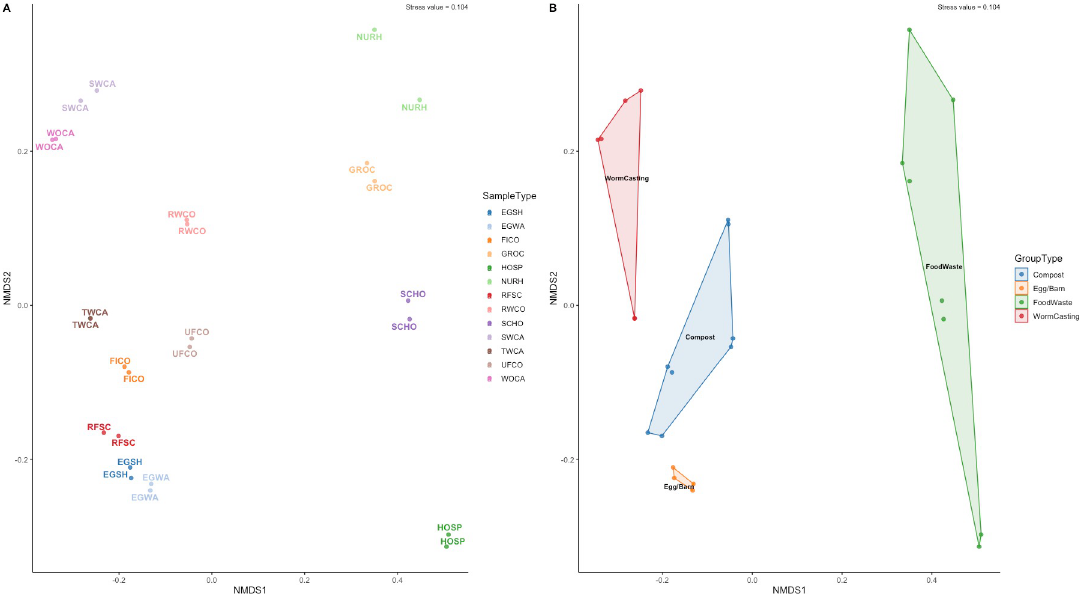
Fig 5. Nonmetric Multidimensional Scaling (NMDS) plot using Bray-Curtis distance of the microbiome of each a) sample and b) group. Food wastes refer to all samples collected off-farm.